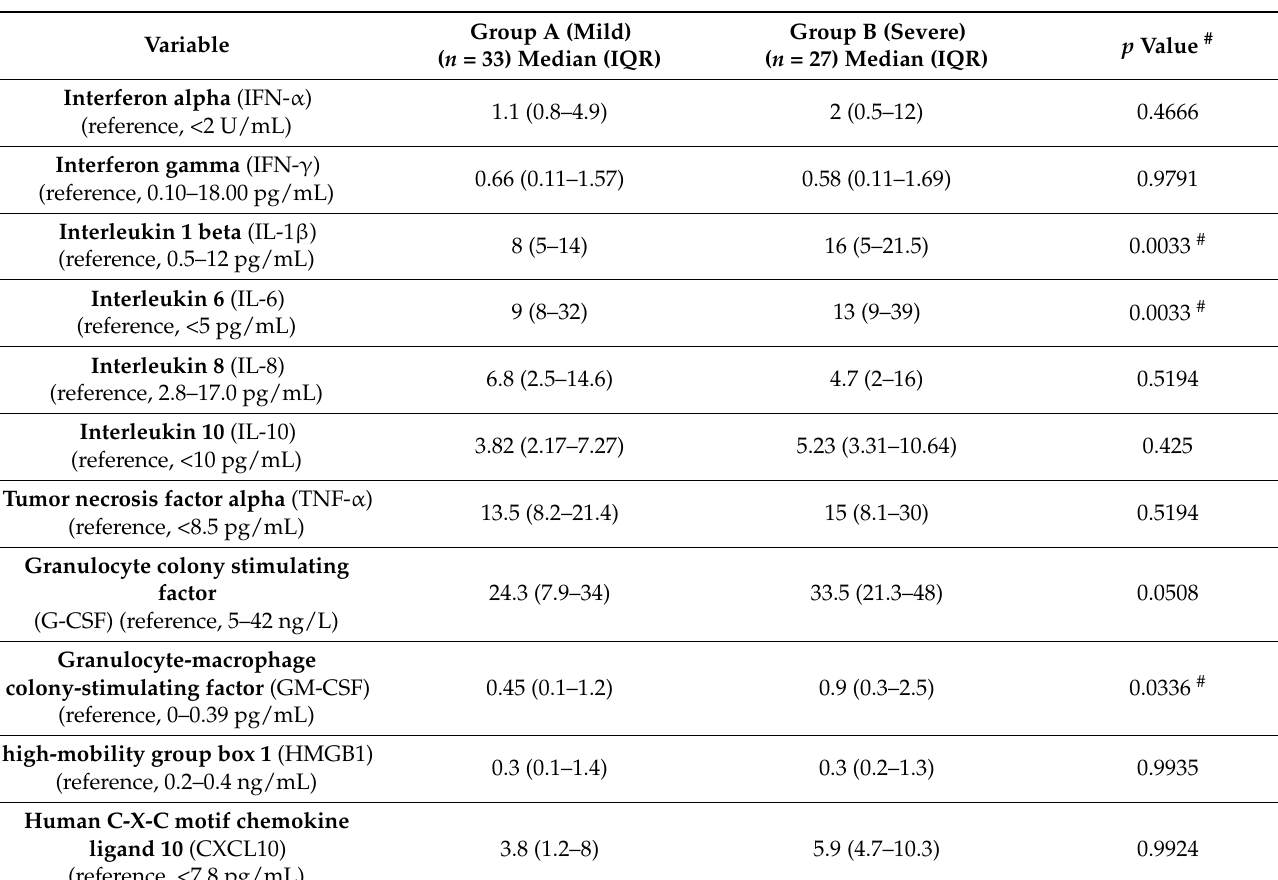
Table 5. Assay of cytokines on Day 14 after admission with MIS-C